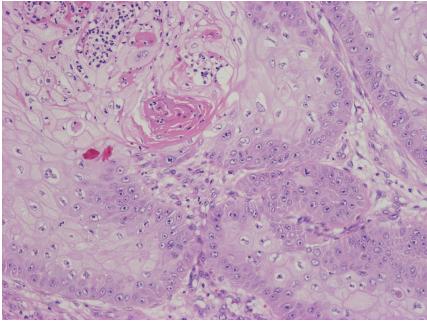
Figure 3: Histologically, the tumor includes papilliform-acantho- sis, a number of cancer pearls, and individual cell